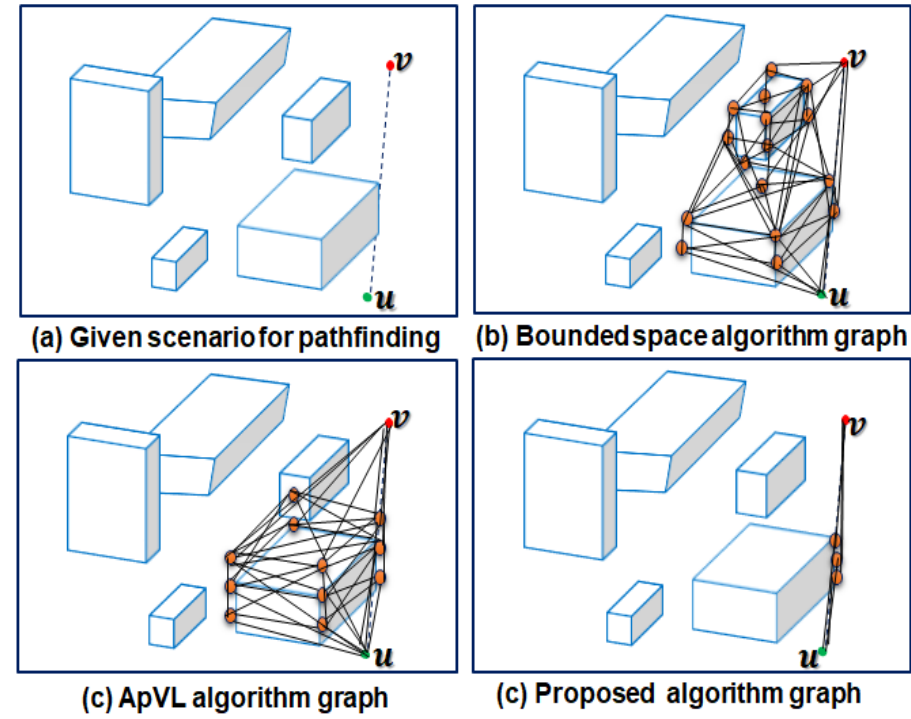
Figure 11. Visibility graph size test: Proposed algorithm versus ApVL and bounded space